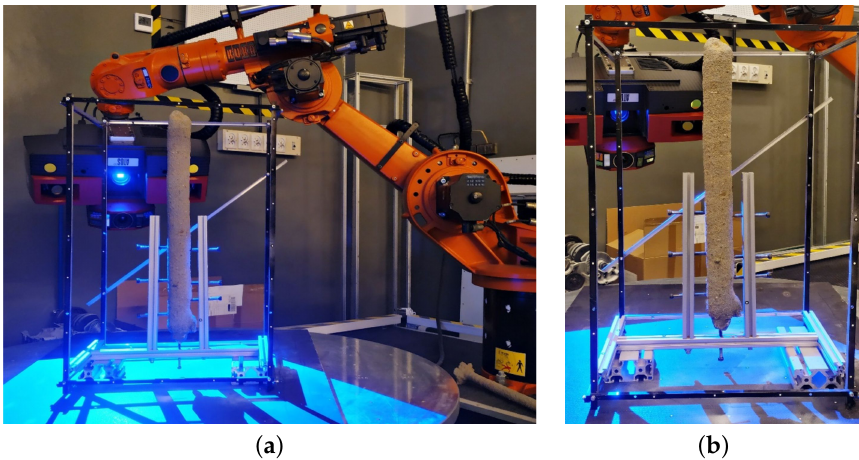
Figure 13. Optical scanning system ( a ) during the measurement of a foundation pile placed in the mea- suring frame, ( b ) a measuring fixture holding the pile still during the measurement.